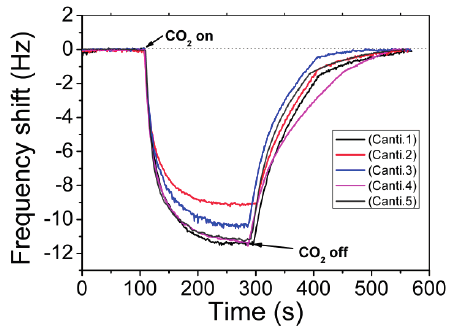
Figure 12. Uniform responses of the five cantilever sensors made in one batch to CO 2 of 1000 ppm concentration. Reprinted with permission from